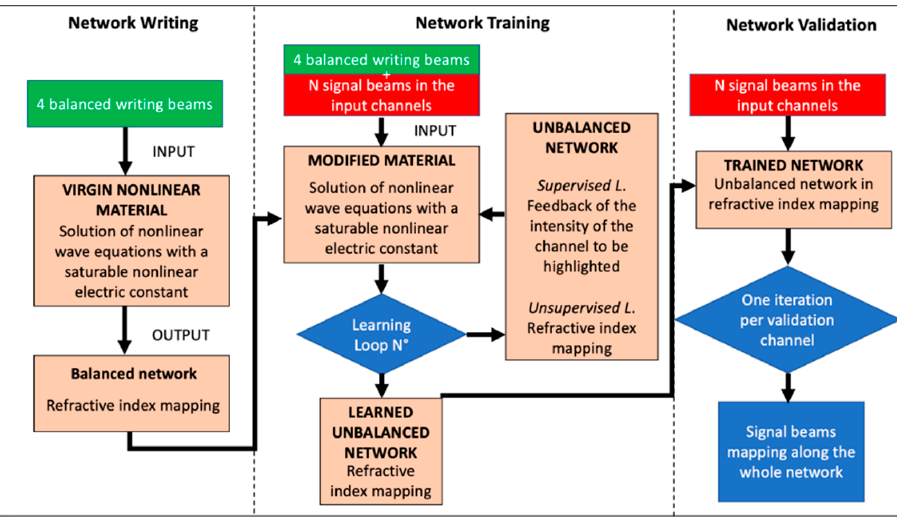
Figure 7. The solver code is divided into three sections: the first one writes a balanced network based on X-junction units by solving the nonlinear wave equations of four light beams within a nonlinear medium. The output of this section corresponds to the refractive index mapping of the junction, which is now used as the initial structure for the propagation of N signal beams, which are injected into 4 input arms (i.e. , an N-digit, 4-bit number). The signal beams would slightly modify specific channels of the network arms. By recursive feedbacks, the network slowly learns the inserted information. The last phase is then the testing one: using a single iteration, further “unknown” signals enter the trained refractive index mapping and generate specific output patterns, depending on whether they are recognized or